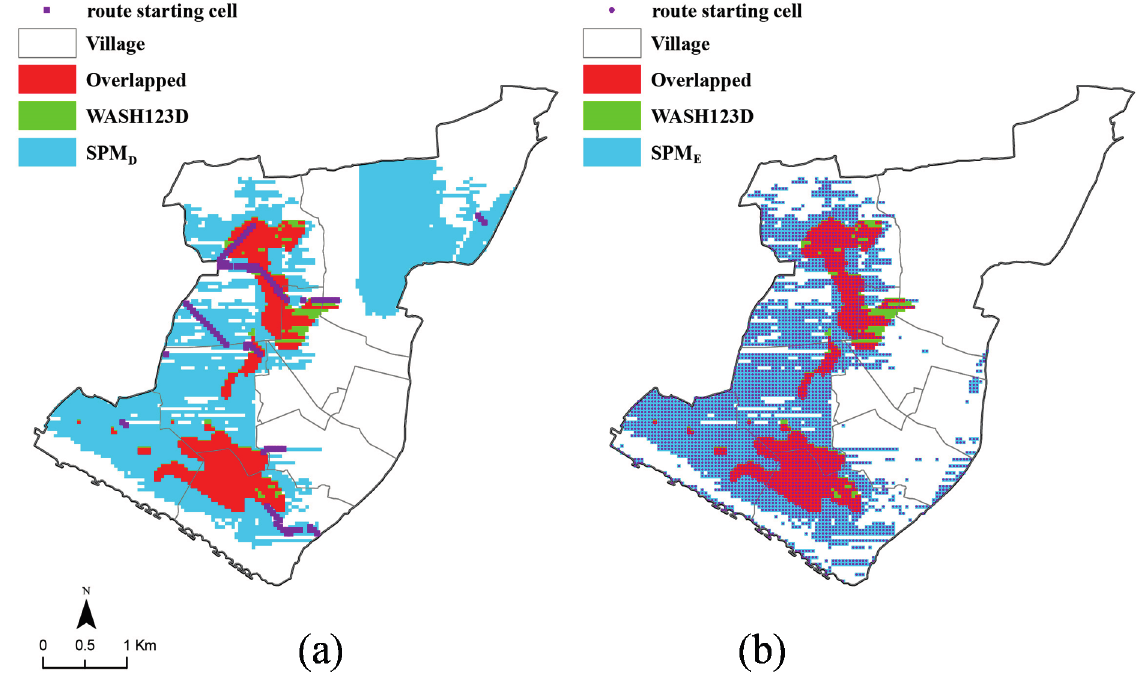
Figure 10. Overlapping flood areas at the grid level between WASH123D and SPM D ( a ) and SPM E ( b ) in Linbian.